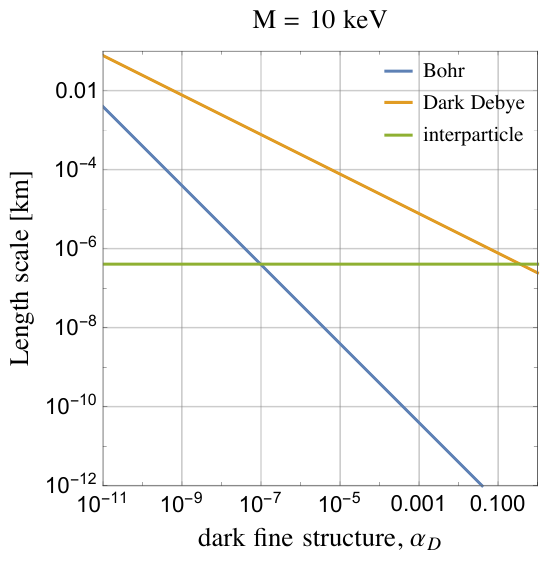
Figure 2 . Here we show the Bohr, dark Debye, and interparticle length scales for an example M = 10 keV monopole as a function of the dark fine structure constant. The notion of a dark Debye length only exists for α . 10 − 7 as described in the D